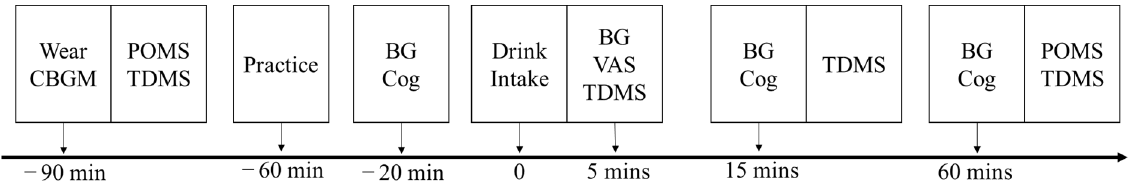
Figure 2. Experimental procedure. Note: CBGM = continuous blood glucose monitoring; POMS = profile of mood state; TDMS = two-dimensional mood scale; BG = blood glucose; Cog = cognitive function assessments; VAS = visual analog scale for drinking.